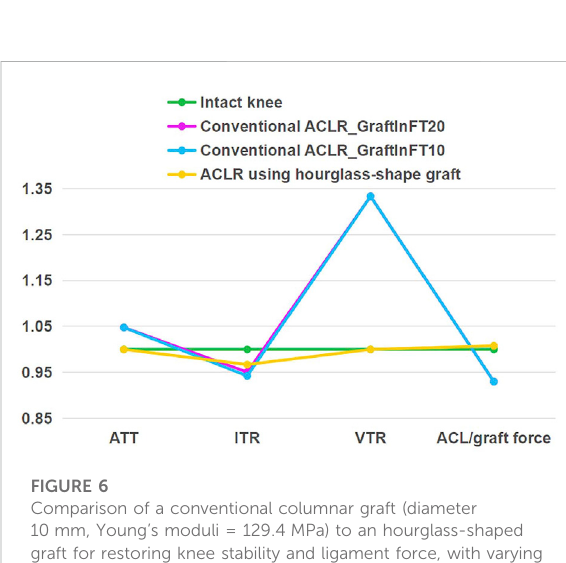
FIGURE 6 Comparison of a conventional columnar graft (diameter 10 mm, Young ’ s moduli = 129.4 MPa) to an hourglass-shaped graft for restoring knee stability and ligament force, with varying position of graft fi xation in the femoral tunnel (10 mm vs. 20 mm) for the conventional ACLR. GraftInFT20 means the graft length inside the femoral tunnel was 20 mm. The values were standardized against an intact knee. ATT, anterior tibial translation; ITR, internal tibial rotation; VTR, valgus tibial